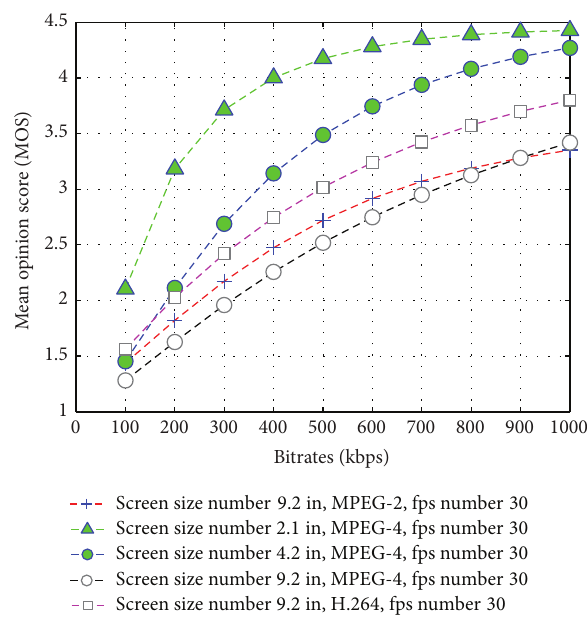
Figure 6: Estimated video quality on N-Screen devices versus